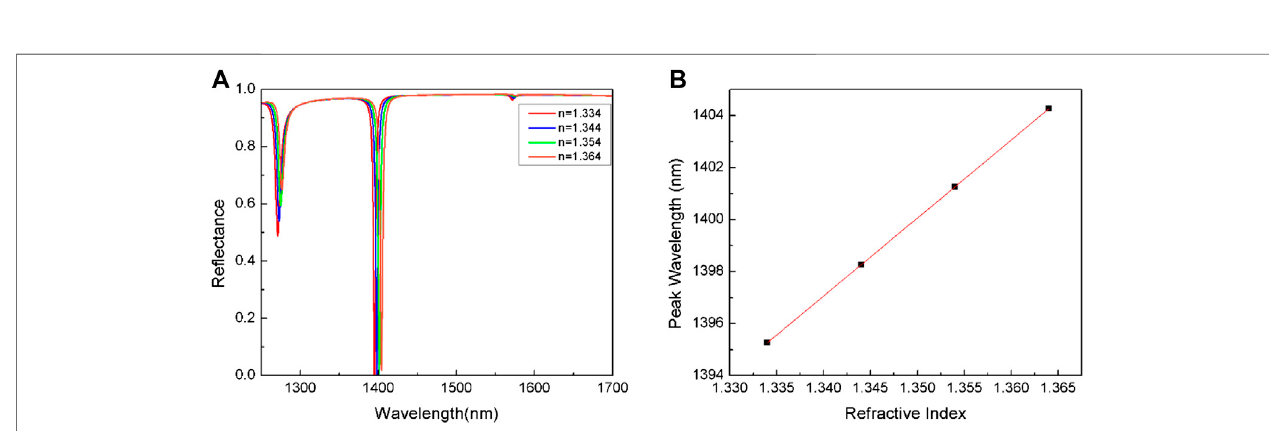
FIGURE 8 | (A) The re fl ectance spectra exposed to different ambient refraction indexes, and (B) the relationship between resonance wavelength and refractive index in 1310 nm structure.